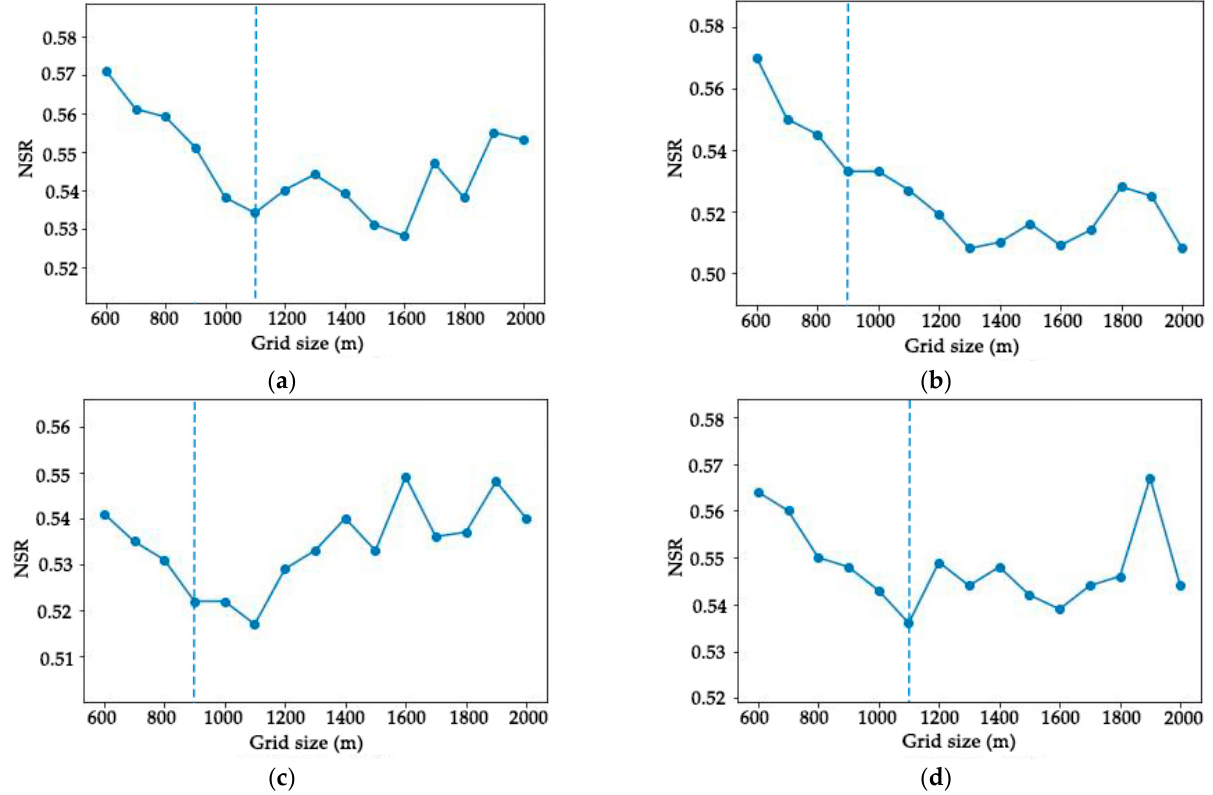
Figure 6. Comparison of size effects and NSR of explanatory variables. ( a ) Pick-up ridership in the morning peak hours; ( b ) drop-off ridership in the morning peak hours; ( c ) pick-up ridership in the evening peak hours; and ( d ) drop-off ridership in the evening peak hours.